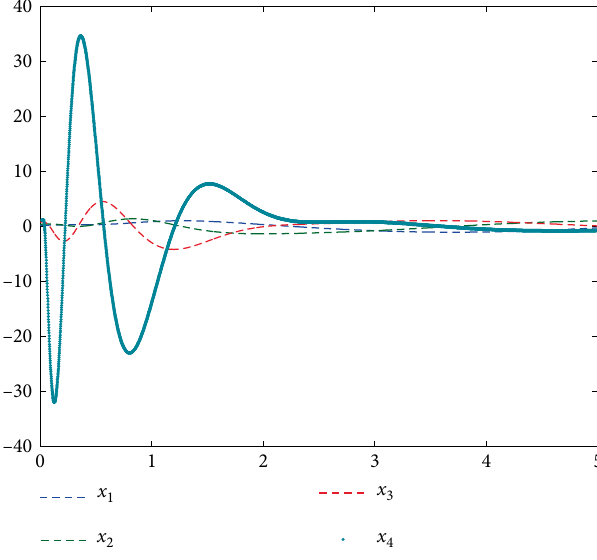
Figure 2: The sampled-data control signal transmitted through network.